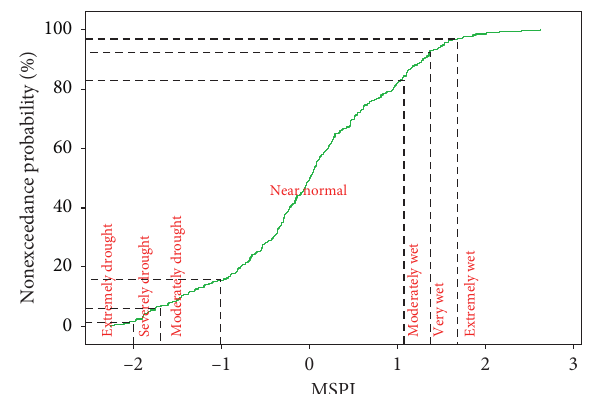
Figure 2: Percentiles of 6 to 12 months’ time window of MSPI for Hamedan synoptic station.